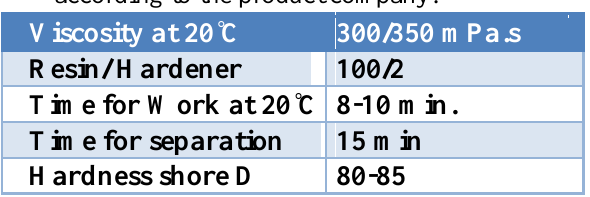
Table, 2: Technical information of PMMA according to the product company.